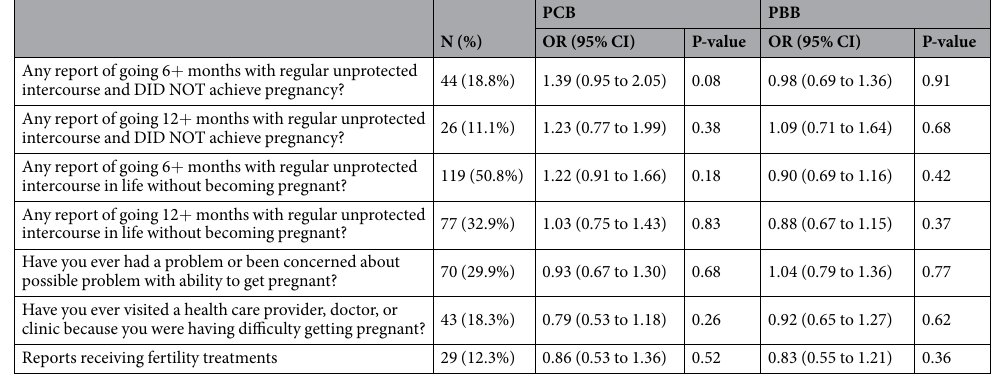
Table 3. Association between exposures and infertility outcomes. Adjusted for age, BMI, and total lipid levels. Total PCB levels adjusted for total PBB and total PBB levels adjusted for total PCB. OR = odds ratio. CI = confidence